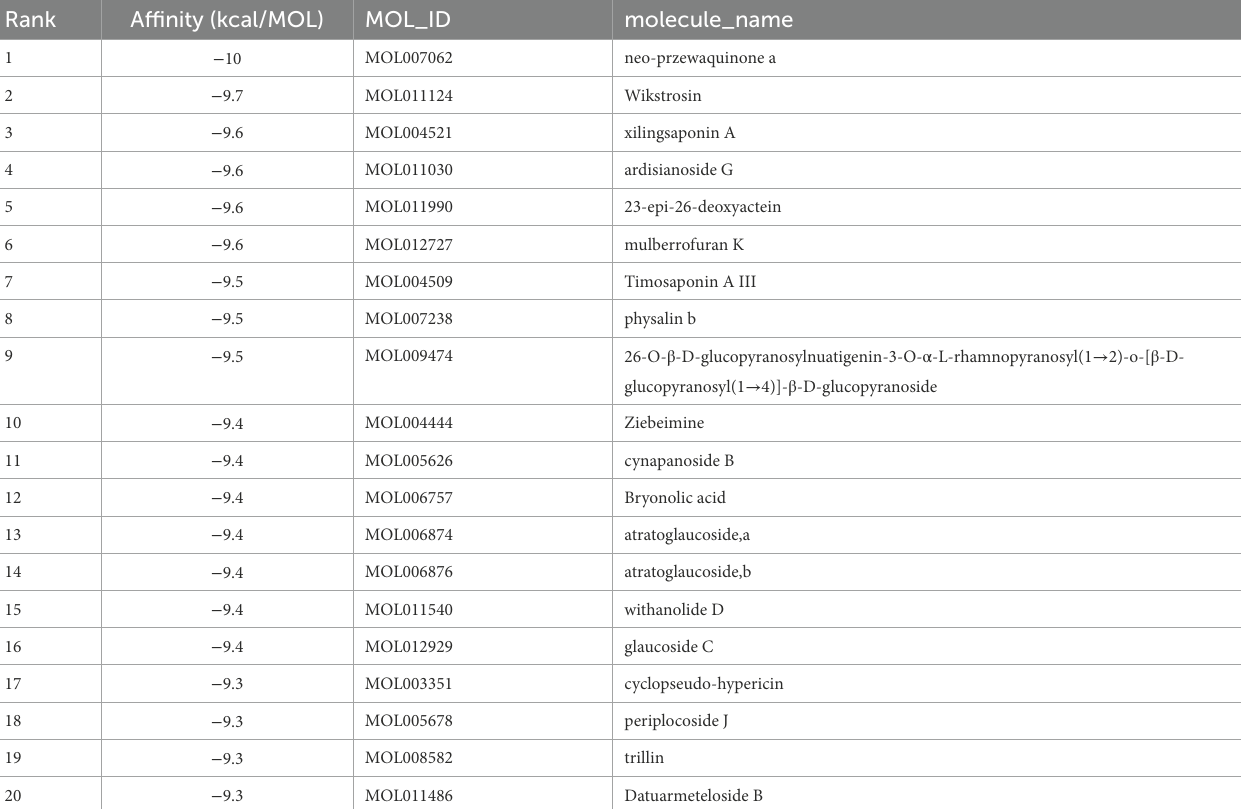
TABLE 2 Molecular docking results of Delta S-CTD and compounds (top 20).